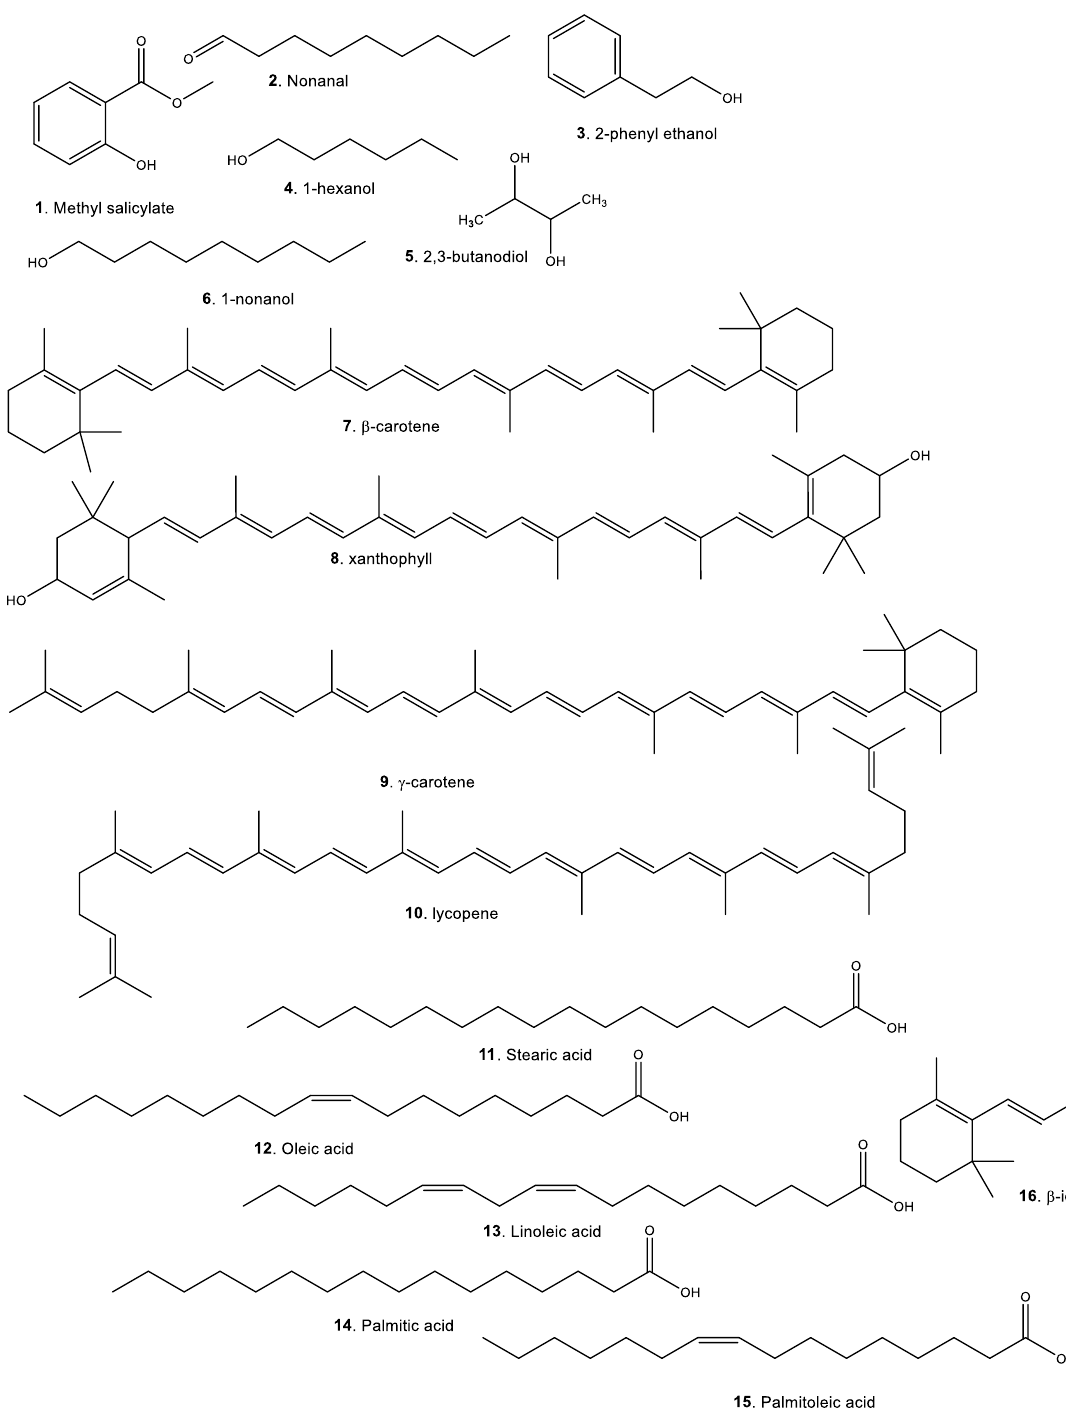
Figure 3. Phytochemical composition of Bactris gasipaes fruit. Major compounds.